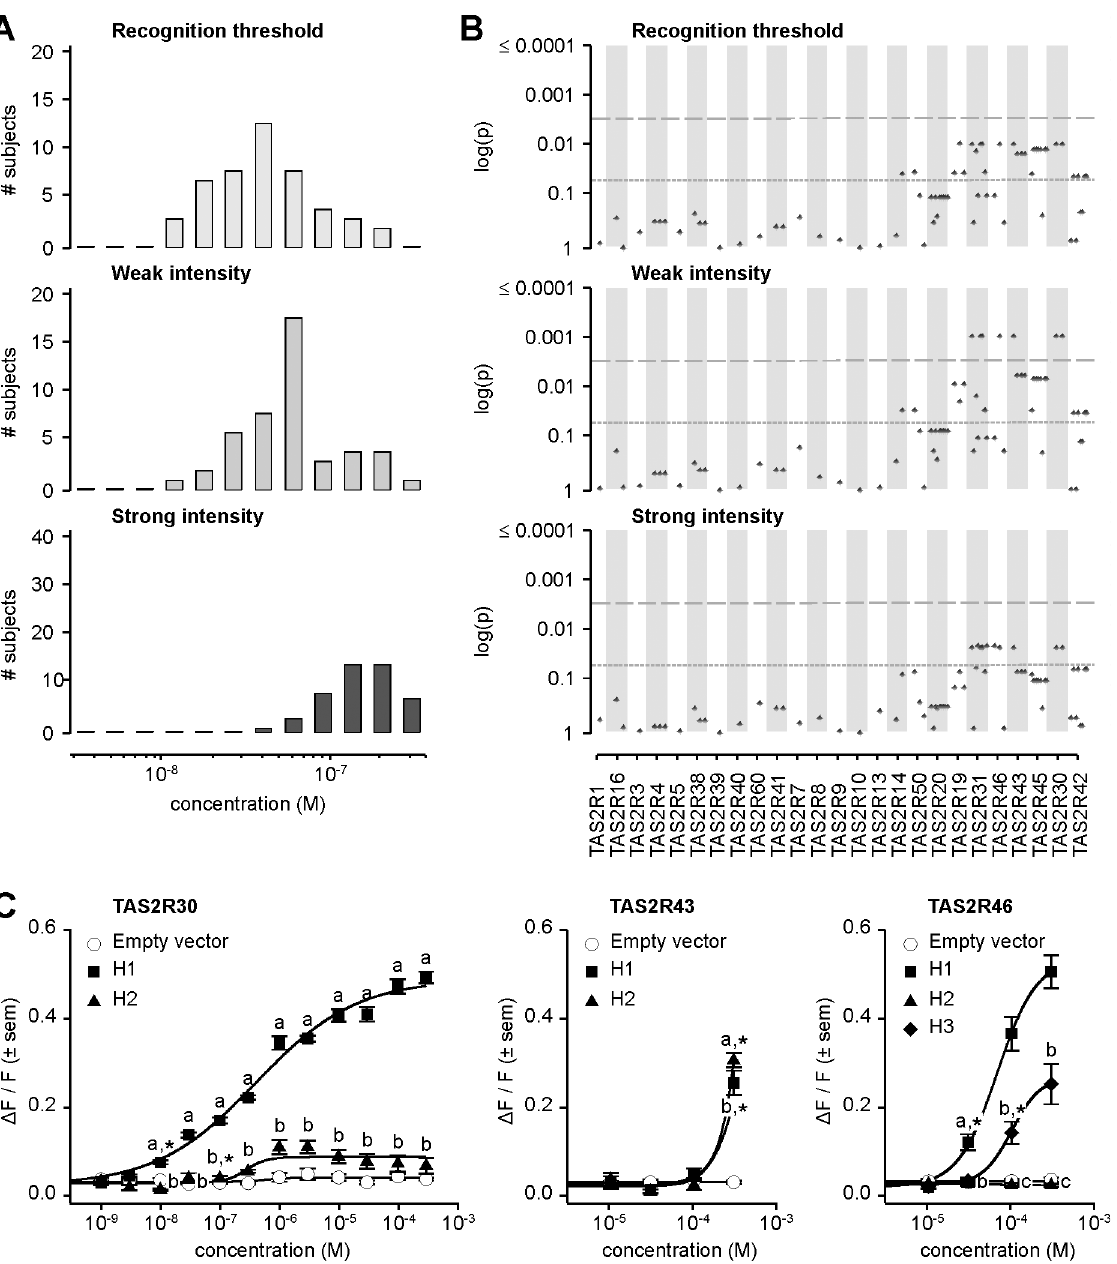
Fig 6. Amarogentin phenotypes, genotype-phenotype associations, and functional assays. (A) Distribution of bitter taste recognition thresholds, and concentrations perceived as weak and strong. (B) Genotype-phenotype associations for common SNPs (frequency > 0.05). Dashed line indicates significance threshold following corrections for multiple testing. Solid line indicates uncorrected significance threshold. (C) Allele-specific dose response curves for loci harboring SNPs showing significant phenotypic associations.